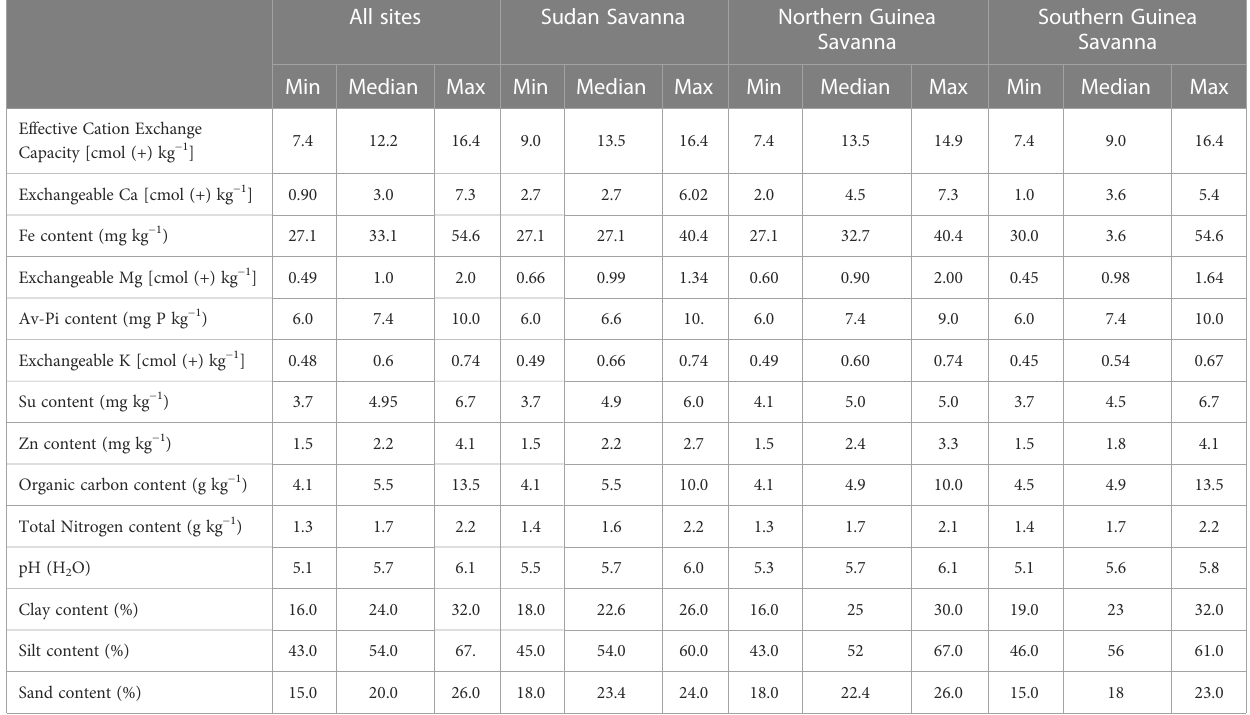
TABLE 2 Maximum (Max), median and minimum (Min) of soil properties from all sampled sites, Sudan, northern Guinea, and southern Guinea Savannas of